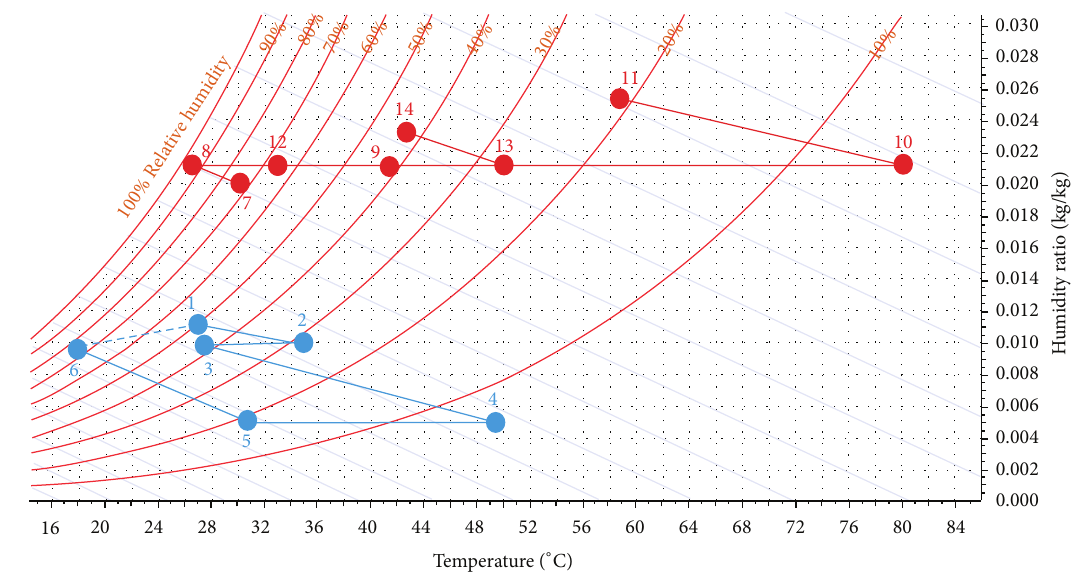
Figure 16: Psychometric chart of two-stage solar desiccant cooling system in recirculation mode.